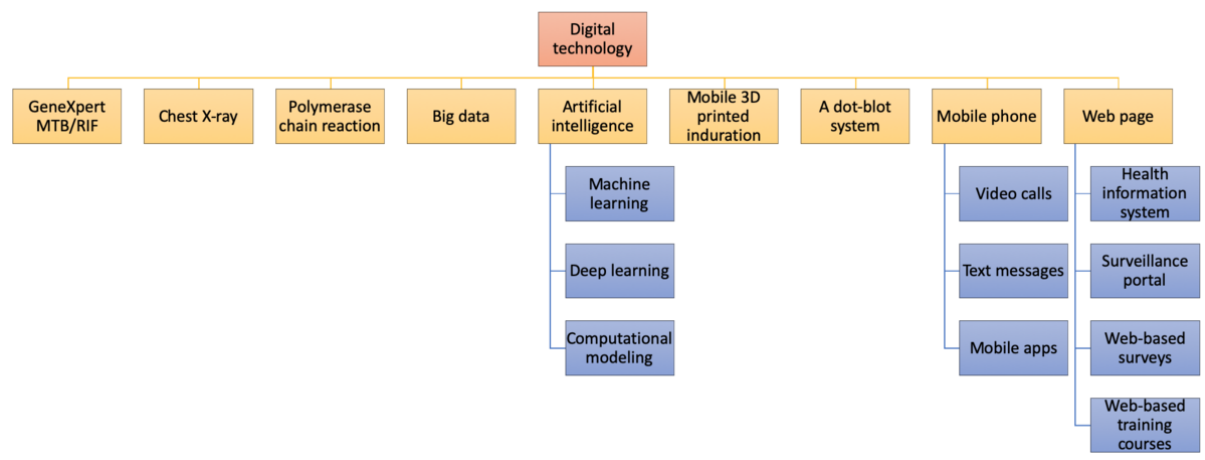
Figure 3. Types of digital technology. MTB: mycobacterium tuberculosis; RIF: